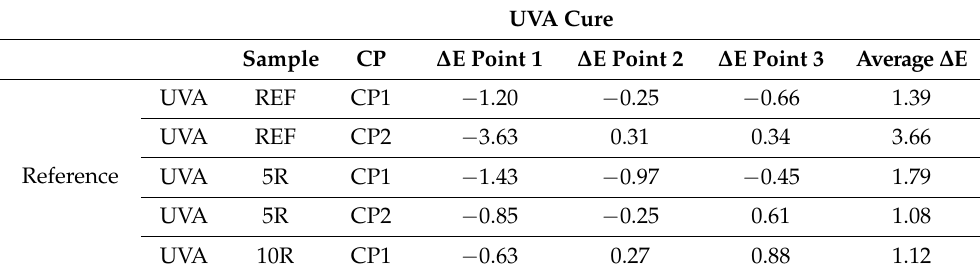
Table A1. Color variation of cement tiles after UVA